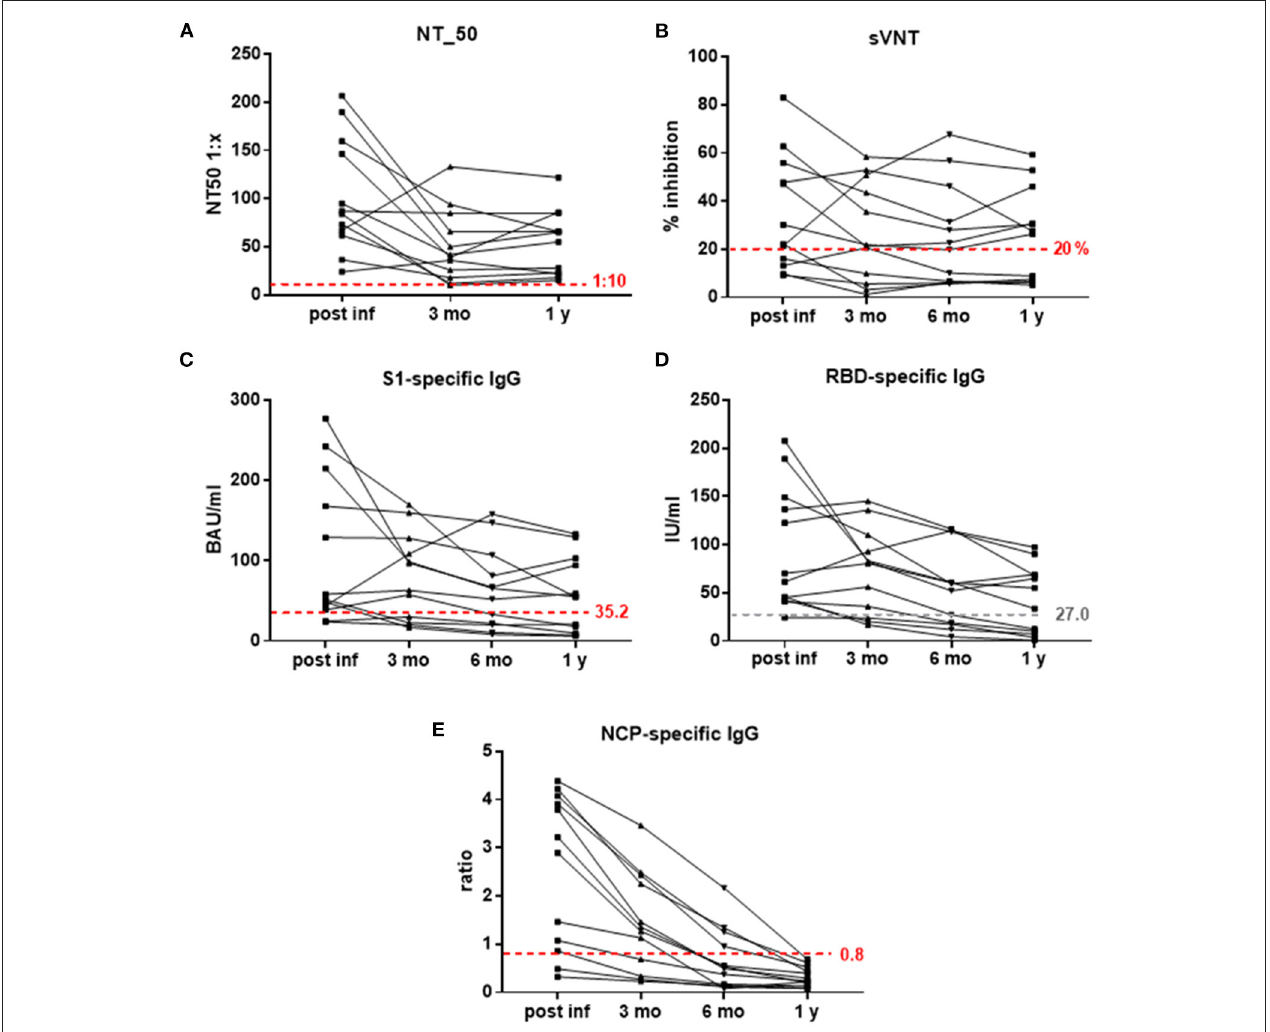
FIGURE 1 | (A–E) Kinetics of SARS-CoV-2-specific Abs measured with different assays. (A) NT_50 titers 1:x, (B) % inhibition in sVNT (negative cut-off 20%), (C) S1-specific IgG in BAU/ml (positive cut-off 35.2), (D) RBD-specific IgG in IU/ml, and (E) NCP-specific IgG (ratios, negative cut-off 0.8) post-infection and 3 months, 6 months and 1 year thereafter; dashed red lines indicate positive (NT_50, S1-specific IgG) and negative (sVNT, NCP-specific IgG) cut-off values; dashed gray line—proposed positive cut-off for RBD-specific IgG. BAU, binding antibody units; IU, international antibody units; NT_50, reciprocal sample dilution resulting in 50% virus neutralization; mo, months; NCP, SARS-CoV-2 nucleo capside protein; RBD, SARS-CoV-2 receptor binding domain; S1, SARS-CoV-2 Spike protein 1; sVNT, surrogate-virus neutralization test; y,